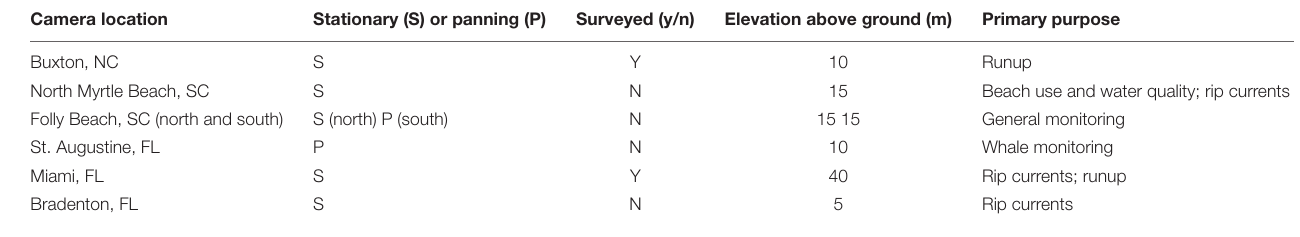
TABLE 1 | WebCAT camera specific information and metadata. Camera